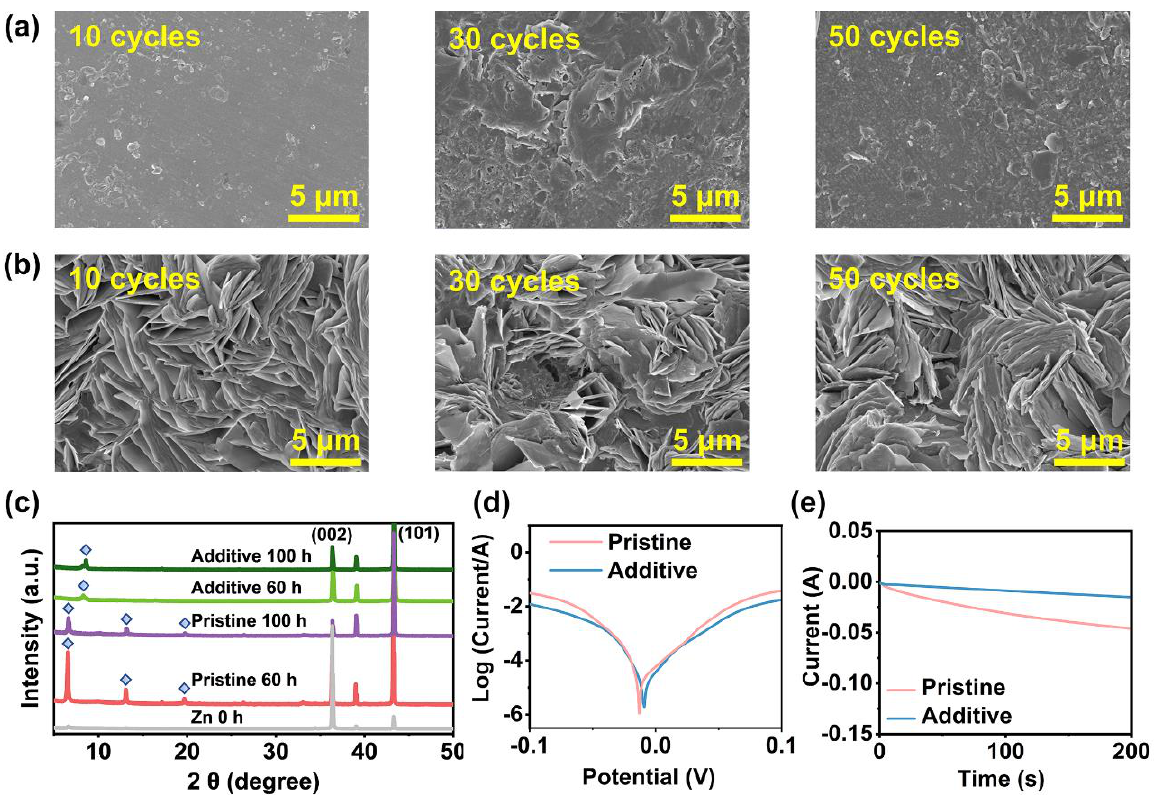
Figure 4. Plating condition of Zn 2+ in Zn|Zn cells. ( a ) Top-view SEM images of Zn anode obtained from Zn|Zn cells with additive-containing electrolyte after cycling at 1 mA cm − 2 . ( b ) Top-view SEM images of Zn anode obtained from Zn|Zn cells with pristine electrolyte after cycling at 1 mA cm − 2 . ( c ) XRD patterns of zinc surface from Zn|Zn cells with additive-containing and pristine electrolyte after cycling at 1 mA cm − 2 . ( d ) Transference number of Zn 2+ with pristine and additive-containing electrolyte. ( e ) Tafel curves of Zn|Zn cells with pristine and additive-containing electrolyte. Chronoamperograms (CAs) of Zn|Zn cells with pristine and additive-containing electrolyte under a −10 mV ov erpotential.